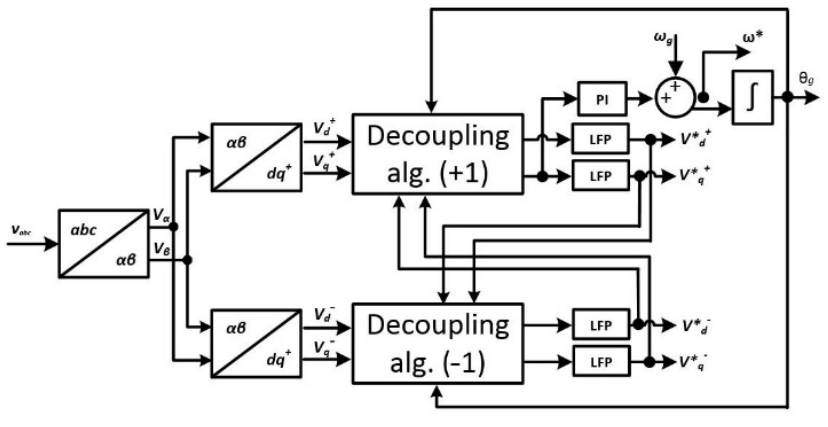
Figure 4. DDSRF-FLL algorithm.